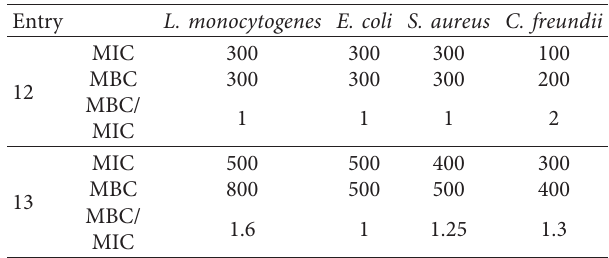
Figure 4: 13 C NMR spectrum N 2 ,N 2 ,N 3 ,N 3 -tetrakis((3,5-dimethyl-1H-pyrazol-1-yl)methyl)pyridine-2,3-diamine (13) . Table 2: MIC (in µ M) and MBC (in µ M) values of active com- Table 1: Antibacterial activity of the newly synthesized mono- and pounds 12 and 13 against the bacterial strains L. monocytogenes tetra-alkylated pyrazole and triazole derivatives determined by the broth macrodilution assay and using the phenol red indicator.